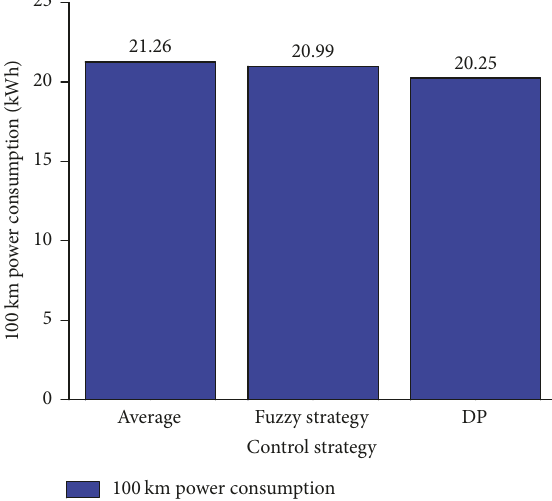
Figure 18: Energy consumption distribution diagram of electric drive system under NEDC road condition.